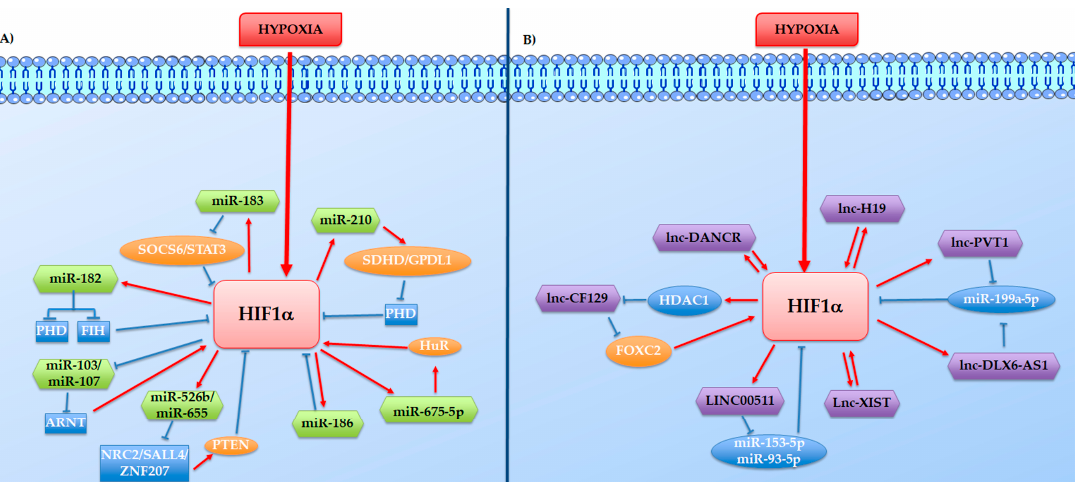
Figure 2. Direct or indirect feedback loops between HIF-1 α and hypoxia-regulated ncRNAs. The hypoxia-regulated ncRNAs, HIF-1 α , and other co-operators intertwine to form reciprocal feedback loops in both positive and negative manners, represented in the figure respectively with red arrows and blue lines. ( A ) Reciprocal feedback loops between HIF-1 α and hypoxia-regulated lncRNAs. ( B ) Reciprocal feedback loops between HIF-1 α and hypoxia-regulated miRNAs.